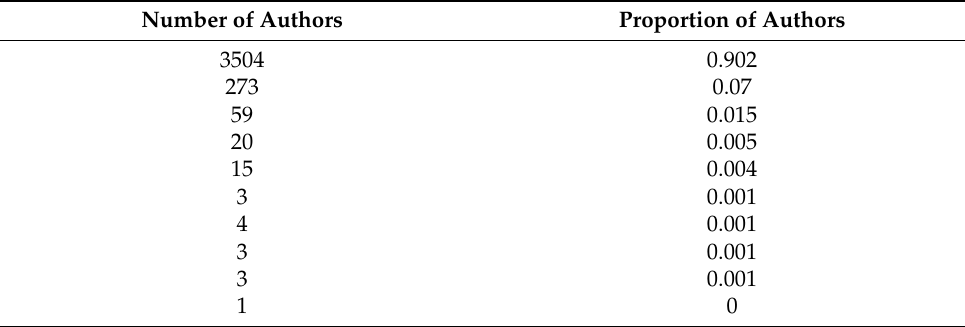
Table 2. Distribution of authors and their publications.